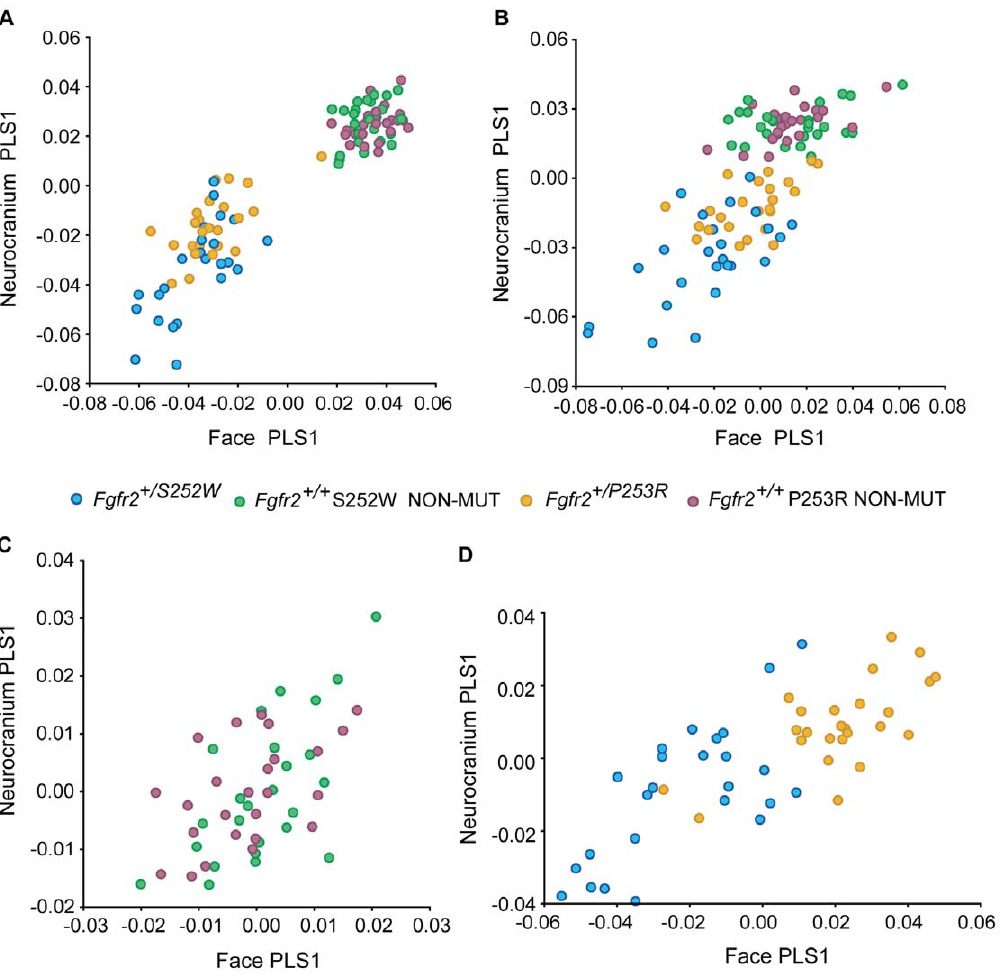
Figure 2. Scatterplots of PLS1 scores of the facial and the neurocranial skeleton using varying subsets of individuals. A) PLS analysis including Apert syndrome mouse models and non-mutant littermates before adjusting for allometry; B) PLS analysis including Apert syndrome mouse models and non-mutant littermates after adjusting for allometry; C) PLS analysis of non-mutant littermates after adjusting for allometry; D) PLS analysis of mutant Apert syndrome mouse models after adjusting for allometry.